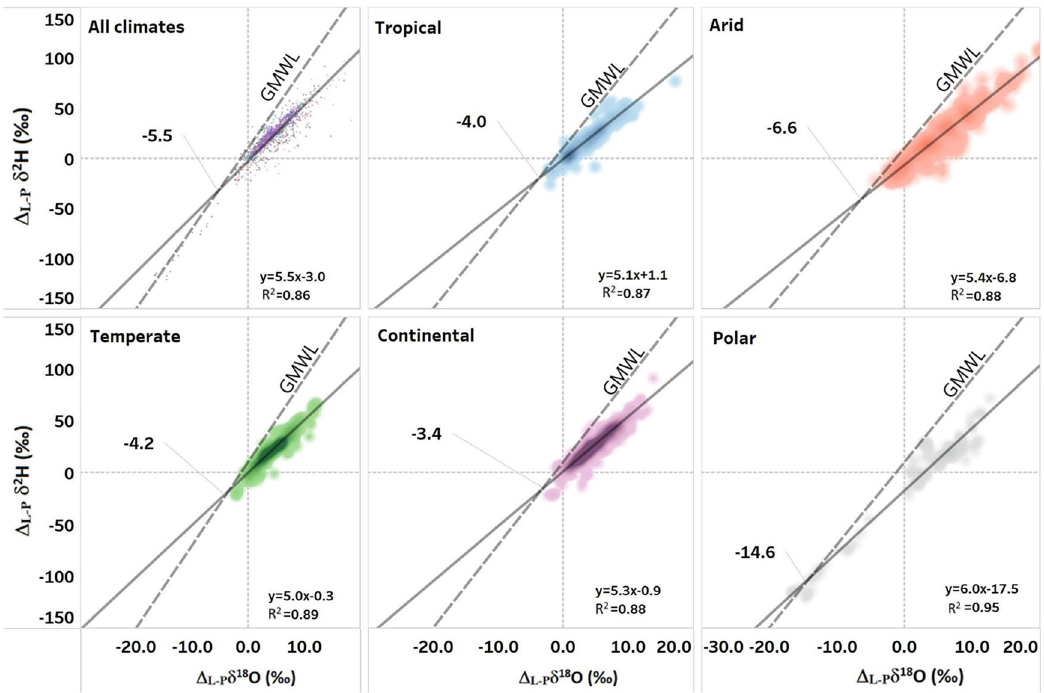
Fig. 2 Isotope evaporation lines for global lakes. The local evaporation lines (LEL) and their coef fi cients of determination ( R 2 ) based on the isotopic values of lakes normalized to their weighted catchment precipitation input ( Δ L-P δ 18 O and Δ L-P δ 2 H) and the intersection of these lines with the global meteoric water line (GMWL). Intersection values refer to δ 18 O values.